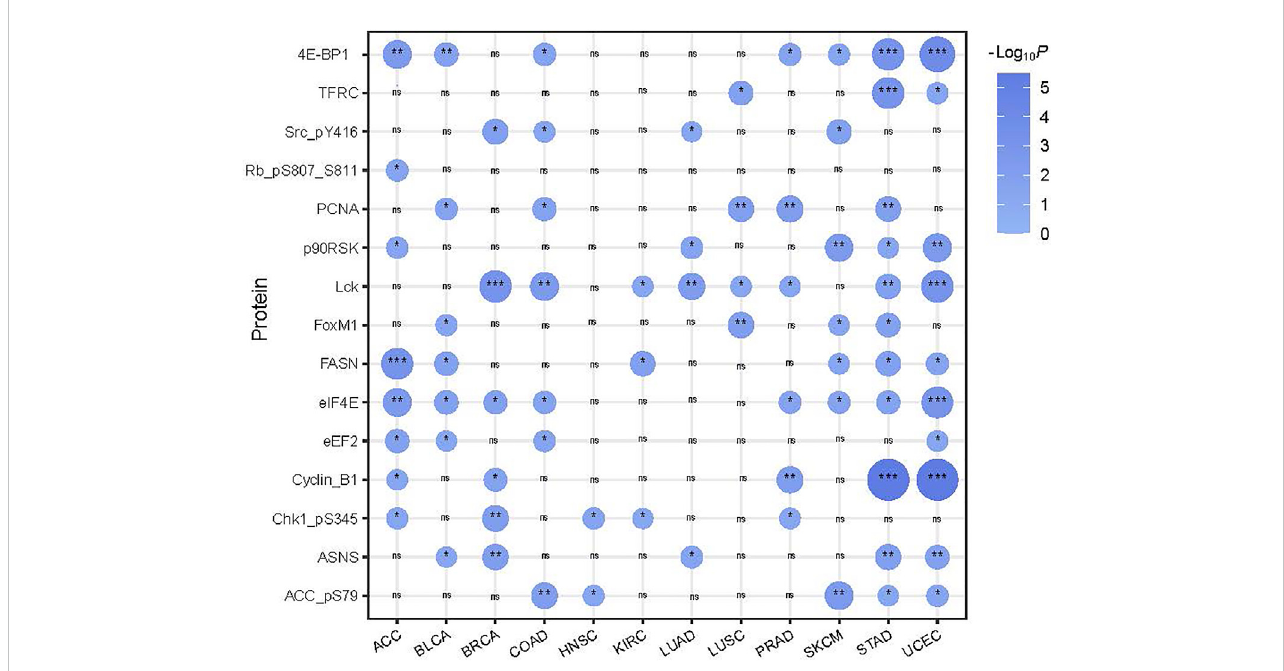
FIGURE 5 15 proteins showing signi fi cantly higher expression levels in SFG-mutated than in SFG-wildtype tumors in at least fi ve cancer types. The two-tailed Student ’ s t test p values are shown.